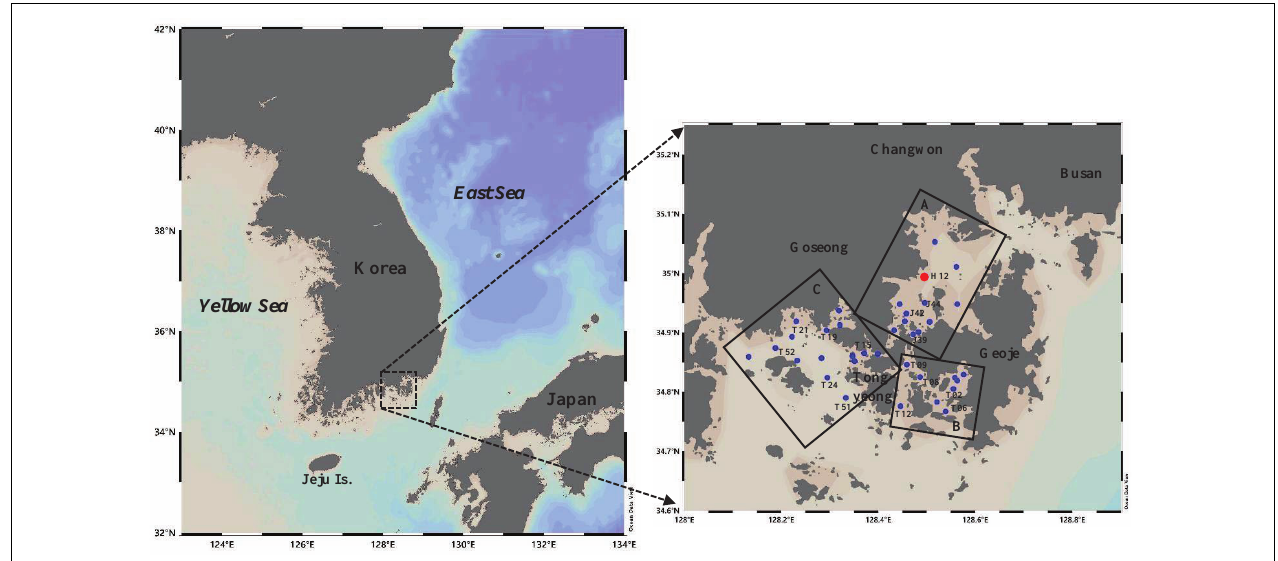
FIGURE 1 | Study site showing the three areas [ A: Jinhae Bay (JB), B: Geoje-Hansan Bay (GHB), C: Tongyeong- Goseong Bay (TGB)] and discrete stations (blue circles) with one hypoxia monitoring station HI2 (red circle).